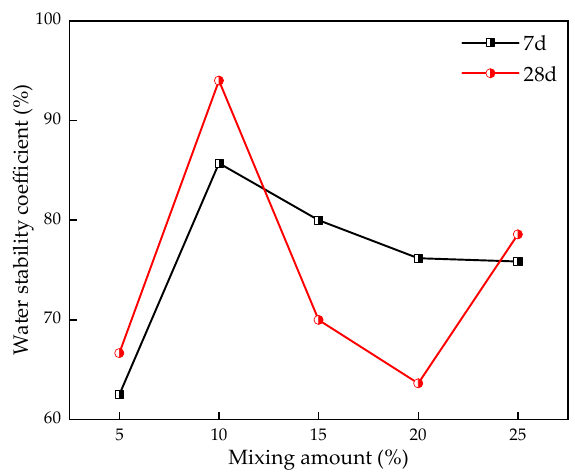
Figure 12. Effect of TS on water stability coefficient of stabilized silt.